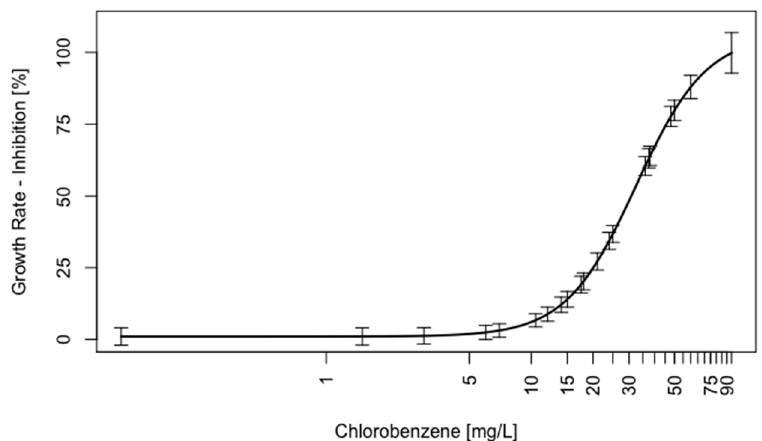
Figure 4. Dose-response curve (4 parameter log-logistic model) of 24 h algal growth inhibition experiments of chlorobenzene. The graph represents data from three independent experiments ( n = 4 per concentration), error bars correspond to 95%-confidence intervals of fitted curve.